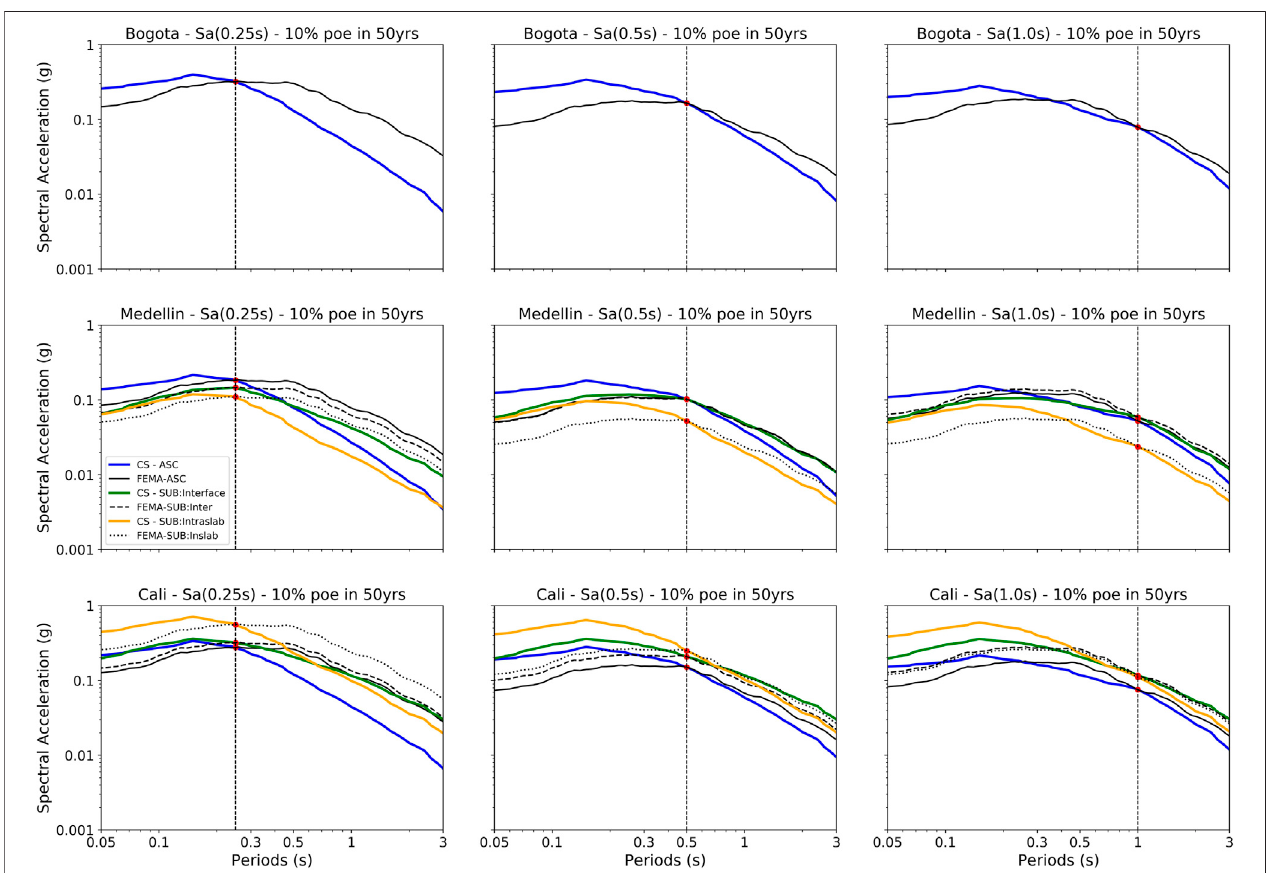
FIGURE11| ComparisonoftheCSandmeanFEMAspectrafor10%probabilityofexceedancein50 yearsforSa(0.25s)left,Sa(0.5s)center,andSa(1.0s)right for the three cities: Bogotá (top), Medellín (center), and Cali (bottom).